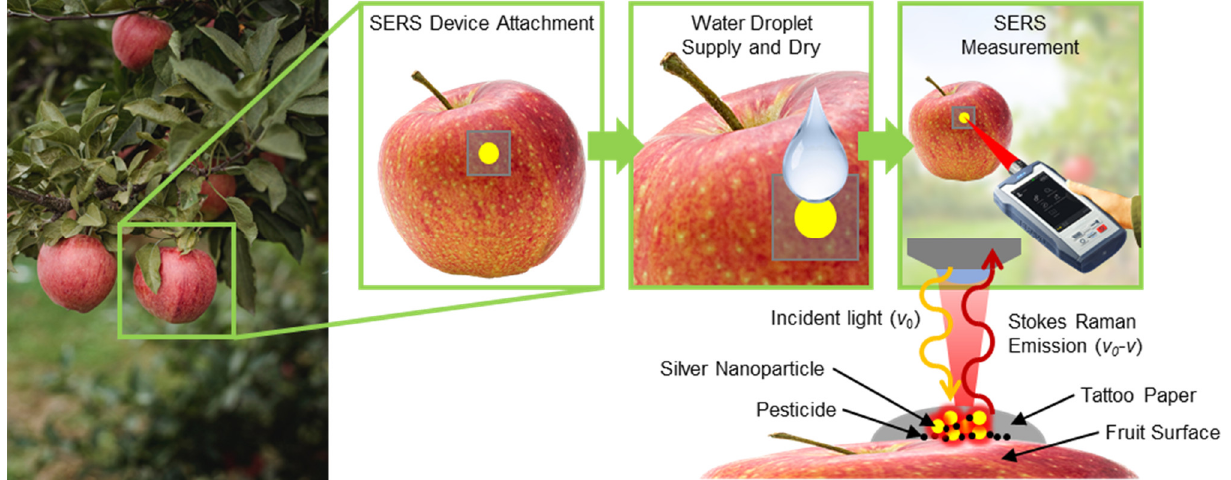
Figure 1. Application of the tattoo paper-based AgNP SERS substrates on a real fruit (apple) sample and identification of the pesticide using a Raman spectrometer.